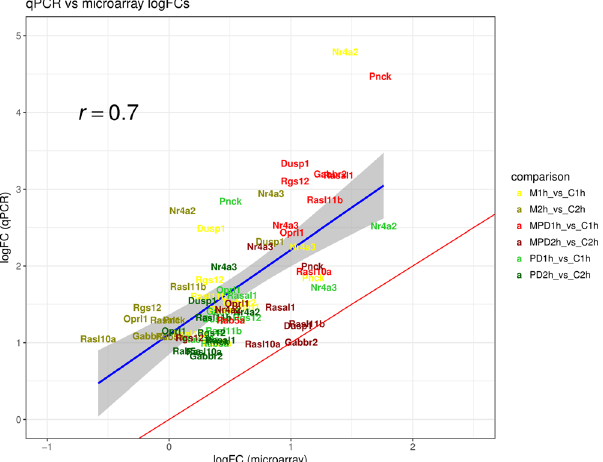
Figure 4. Results of the technical validation by qRT-PCR. Scatterplot of the logFC-s (log 2 Fold-change) obtained with microarrays and with qRT-PCR (qPCR) for the 11 genes included in the validation across 6 treatment vs control comparisons. The red line is the perfect validation line (x = y), that is, the line where genes would lie if their logFC-s were equal for both platforms. The blue line represents the association between the logFC profiles from each platform as given by a linear regression, with the shadow reflecting the 95% confidence